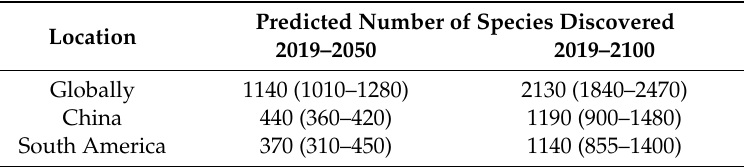
Figure 3. Observed species descriptions ( red ) with predicted species description curves ( black ) from the NHRP model for Global, China, and South America. Dashed lines are 95% confidence intervals. Table 3. The estimated number of species remaining to be discovered with a 95% probability of the estimate falling within the range provided in parentheses.